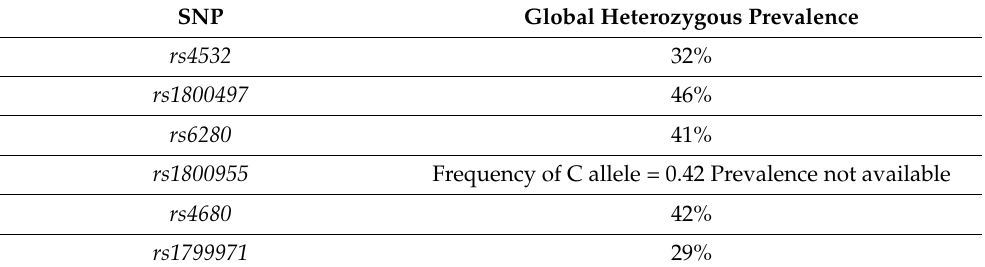
Table 6. Global heterozygous